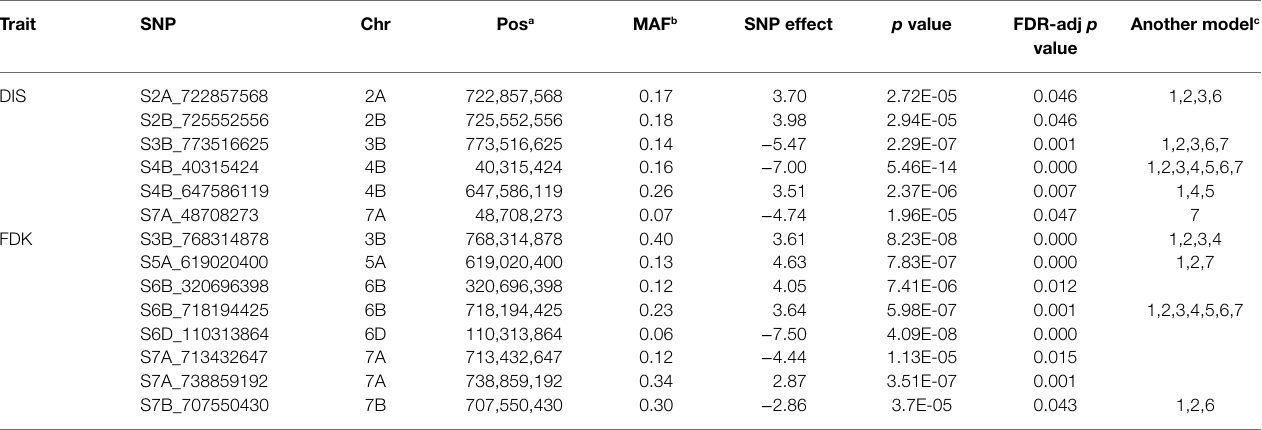
TABLE 2 | Significant marker-trait associations (MTAs) identified by genome-wide association studies (GWAS) using the FarmCPU model for FHB disease index (DIS) and Fusarium-damaged kernels (FDK) in the hard winter wheat panel of 257 breeding lines. Trait SNP Chr Pos